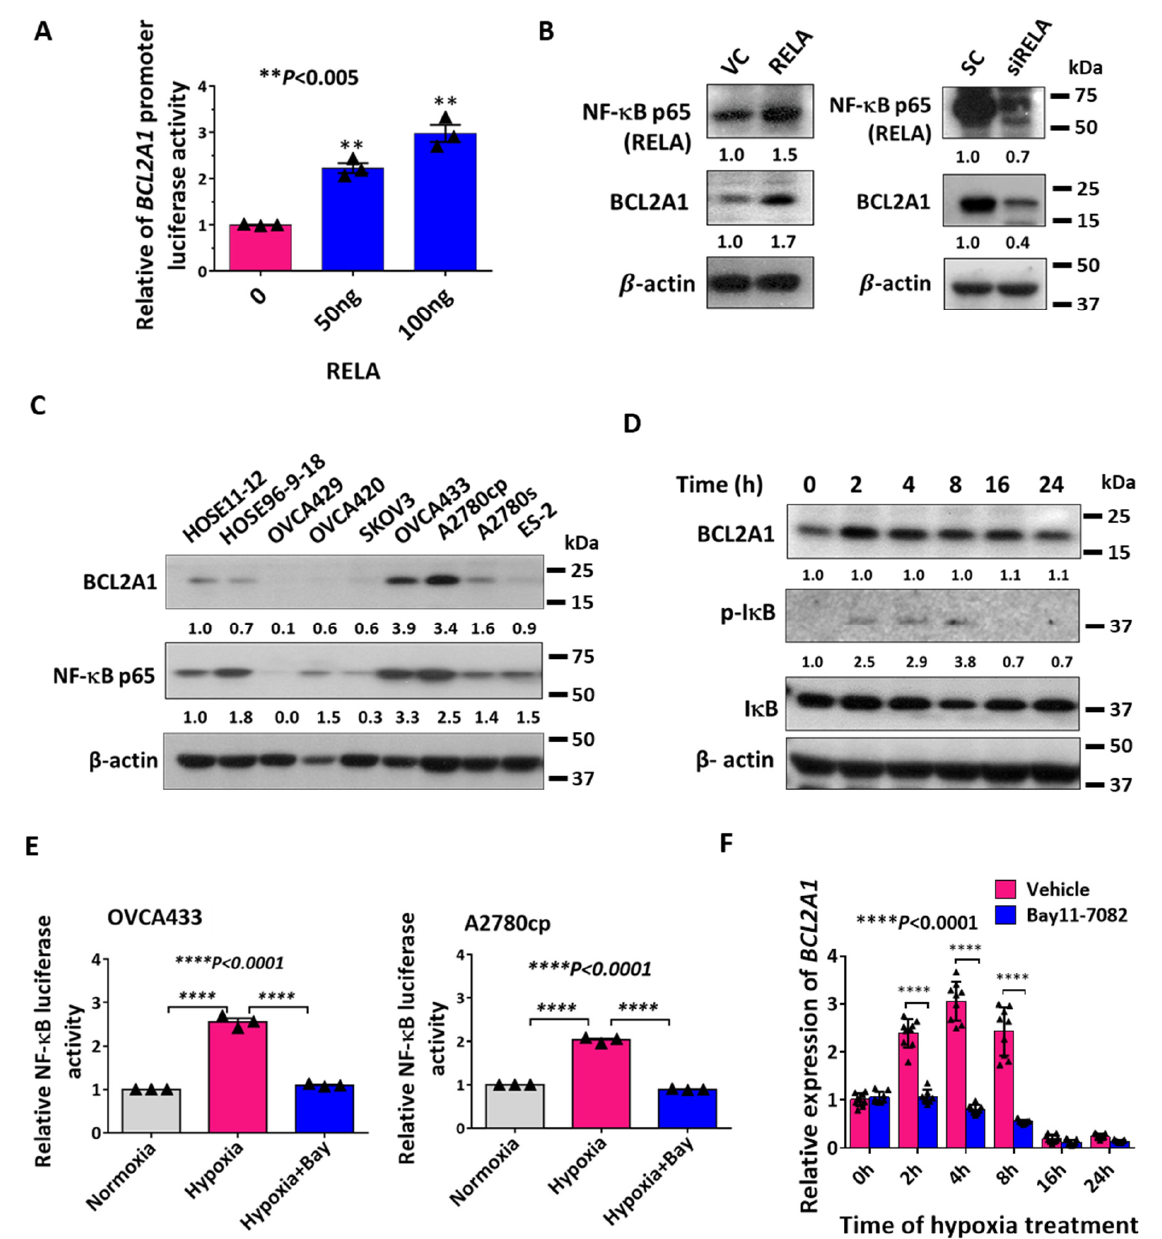
Figure 2. NF- κ B signaling is required for the induction of BCL2A1 by hypoxia. ( A ) BCL2A1 promoter-luciferase assay showed that NF- κ B p65 (RELA) enhanced the BCL2A1 transcriptional activity dose-dependently in OVCA433 cells (** p < 0.005) as compared with control. ( B ) Western blot analysis showed that ectopic expression of NF- κ B p65 (RELA) increased the expression level of BCL2A1, left. Depletion of RELA by siRNAs reduced the expression level of BCL2A1 as compared to the control cells when cultured in hypoxia (0.5% O 2 ) for 8 h. ( C ) Western blot analysis displayed that the expression levels of BCL2A1 and NF- κ B p65 in a panel of ovarian cancer cells. HOSEs cell lines were used as normal control. ( D ) The induction of BCL2A1 is associated with the activation of NF- κ B signaling pathway. OVCA433 cells were treated with hypoxia (0.5% O 2 ) for different time points within 0–24 h. ( E ) NF- κ B luciferase assay showed that NF- κ B transcription activity was increased by hypoxia at 8 h, while NF- κ B inhibitor Bay 11-7082 (10 μ M) abrogated such NF- κ B induction in OVCA433 and A2780cp cells. ( F ) QPCR assay showed that Bay 11-7082 treatment (10 μ M) abolished the upregulation of BCL2A1 mRNA level upon hypoxia treatment. For all, n = 3 technical replicates per sample. Data were represented as mean ± S.E.M.